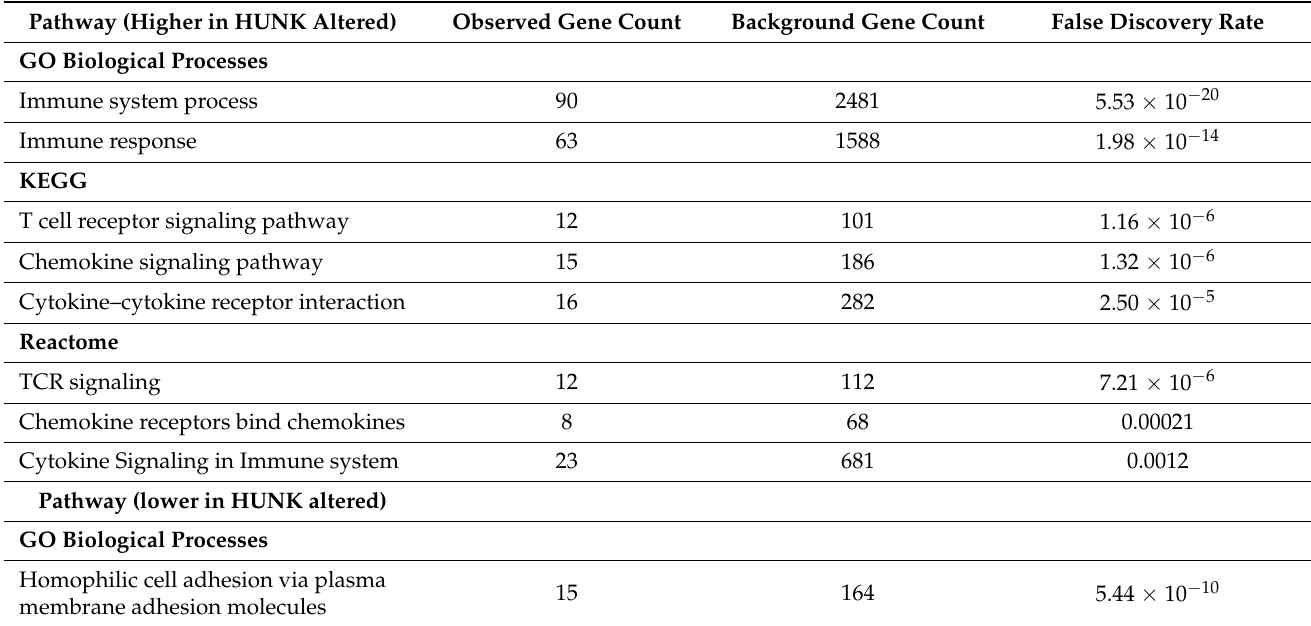
Table 1. mRNA analysis: Factors that were over-represented in the HUNK altered group assessed using GO Biological Processes, KEGG, and Reactome databases that were consolidated by the STRING